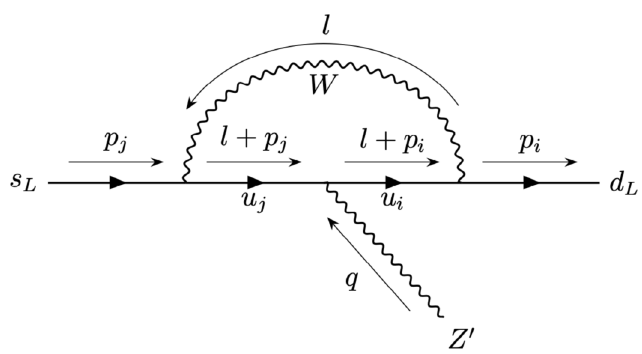
Figure 1 . 1-loop diagram from FCNC coupling of Z 0 in up-type quark sector. Each momentum is defined